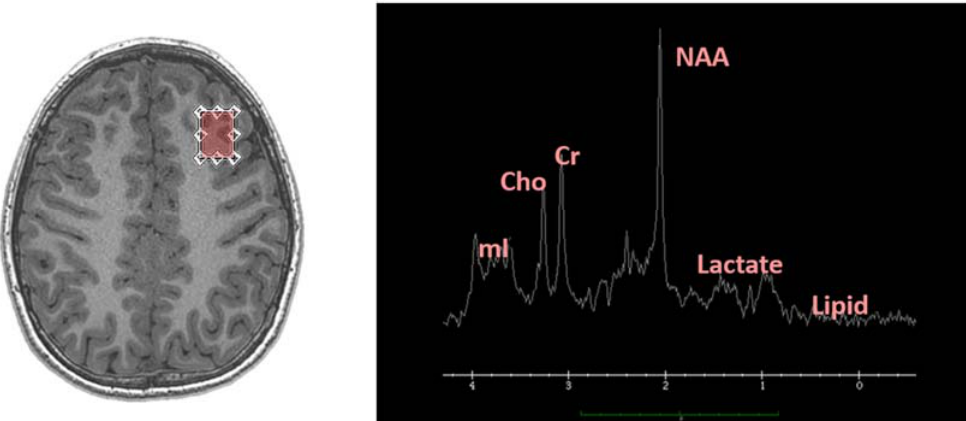
Figure 2. The left panel shows an axial slice of a T1-weighted anatomical scan of a symptomatic mTBI patient generated from a 3.0T scanner. The box indicates the dorsolateral prefrontal cortex (DLPFC) prescription, the selected single-voxel region of interest (ROI) where Magnetic resonance spectroscopy (MRS) data are collected from. The right panel is the MRS output from the same patient. The different peaks are labeled and show relative concentrations of corresponding metabolites.